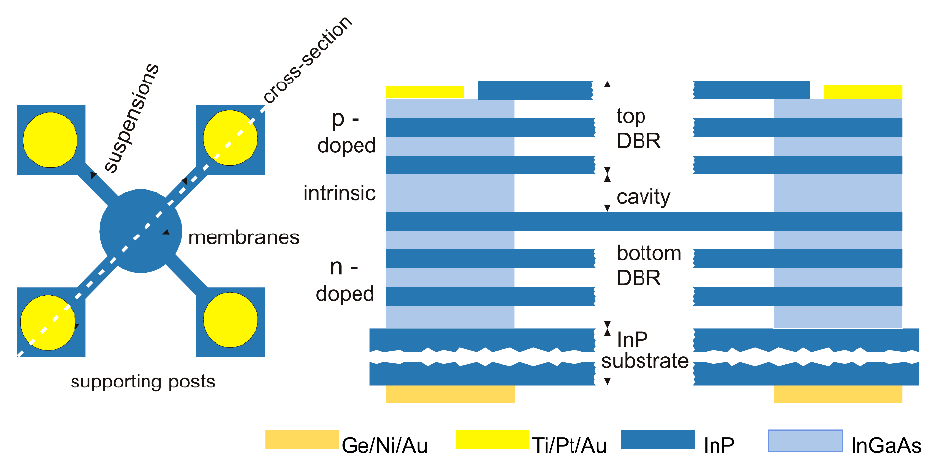
Figure 13. ( Left ) top view on an InP filter element showing four supporting posts with four contact pads (yellow), four suspensions and the top membrane (the topmost one out of the six membranes). The orientation of cross section on the right is indicated by the white broken line. ( Right ) cross section of the MEMS multilayer structure. InGaAs exists only inside the supporting posts. Between the suspensions and central membranes, InGaAs was serving as a sacrificial layer and had been selectively removed and replaced by air. The bottom contacts are shown in orange. Metal organic chemical vapor epitaxy (MOCVD) is applied to grow the required lat- tice-matched multi heterostructure on [100] n-InP substrates: λ air /4 InGaAs layers alternat- ing in the stack with 3 λ InP /4 InP membranes. The λ air /4 InGaAs layers act as sacrificial lay- ers and are eventually etched, transforming into air-gaps. The top DBR located above the air-gap cavity is p-doped, and the bottom DBR layers located below the air-gap cavity is n-doped. First, the contacts are defined by lithography, evaporation and lift-off directly on the epitaxial structure. Then, Si 3 N 4 is deposited by PECVD, and lithography and reac- tive ion etching (5.1 sccm Ar, 3.5 sccm CHF3, 6.7 Pa, 100 W) is used to generate the Si 3 N 4 etch mask. Only the uncovered parts of the semiconductor surface are dry-etched in ver- tical direction using reactive ion etching (20 sccm CH 4 , 70 sccm H 2 , 4.7 Pa, 200 W) to achieve an etch depth down to ~5.5 µm. Use of a Si 3 N 4 mask instead of a resist mask re- veals improved selectivity in the dry-etching process and avoids polymer deposition which is highly unsought on the side walls of the mesa. This process is non-selective and provides vertical side walls, and sharp edges. Then, the etch mask is removed by wet- chemical etching (HF/H 2 O), producing pure semiconductor mesa. The supporting posts are masked by a protective layer to avoid underetching. To underetch the InP membranes, FeCl 3 /H 2 O is used to selectively remove the InGaAs sacrificial layers with an excellent selectivity of about 1000. The precise value depends on doping and temperature. This provides very smooth semiconductor/air interfaces. An etching time of 35 minutes at a temperature of 21 °C is used. It is important that the membranes and suspensions are underetched completely to ensure free vertical motion. The final structure after critical point drying and removal of the protection mask is depicted in Figure 13. A total of 500 filter elements were fabricated simultaneously on a wafer area of 1 cm 2 . The chance was used to fabricate multiple design variants differing in suspension lengths and membrane diameters on the same wafer. The filter variants have membrane diameters of 15–40 µm with three or four suspensions of 10–80 µm length and 10 µm width connecting the mem- brane to the supporting posts. Straight or bent suspensions and circular or square mem- branes were implemented. Figure 14 displays the scanning electron microscope (SEM) images of filters with four suspensions. The optical quality of the two surfaces of each membrane is guaranteed by the high quality of the epitaxial heterointerfaces which is preserved in the selective chem- ical etching step, providing very low optical roughness. Our surface micromachining fab- rication process demands no micro-mounting since the entire structure is fabricated in a